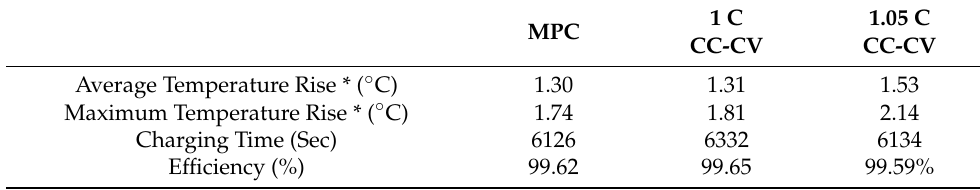
Table 6. Experimental results of different charging methods.